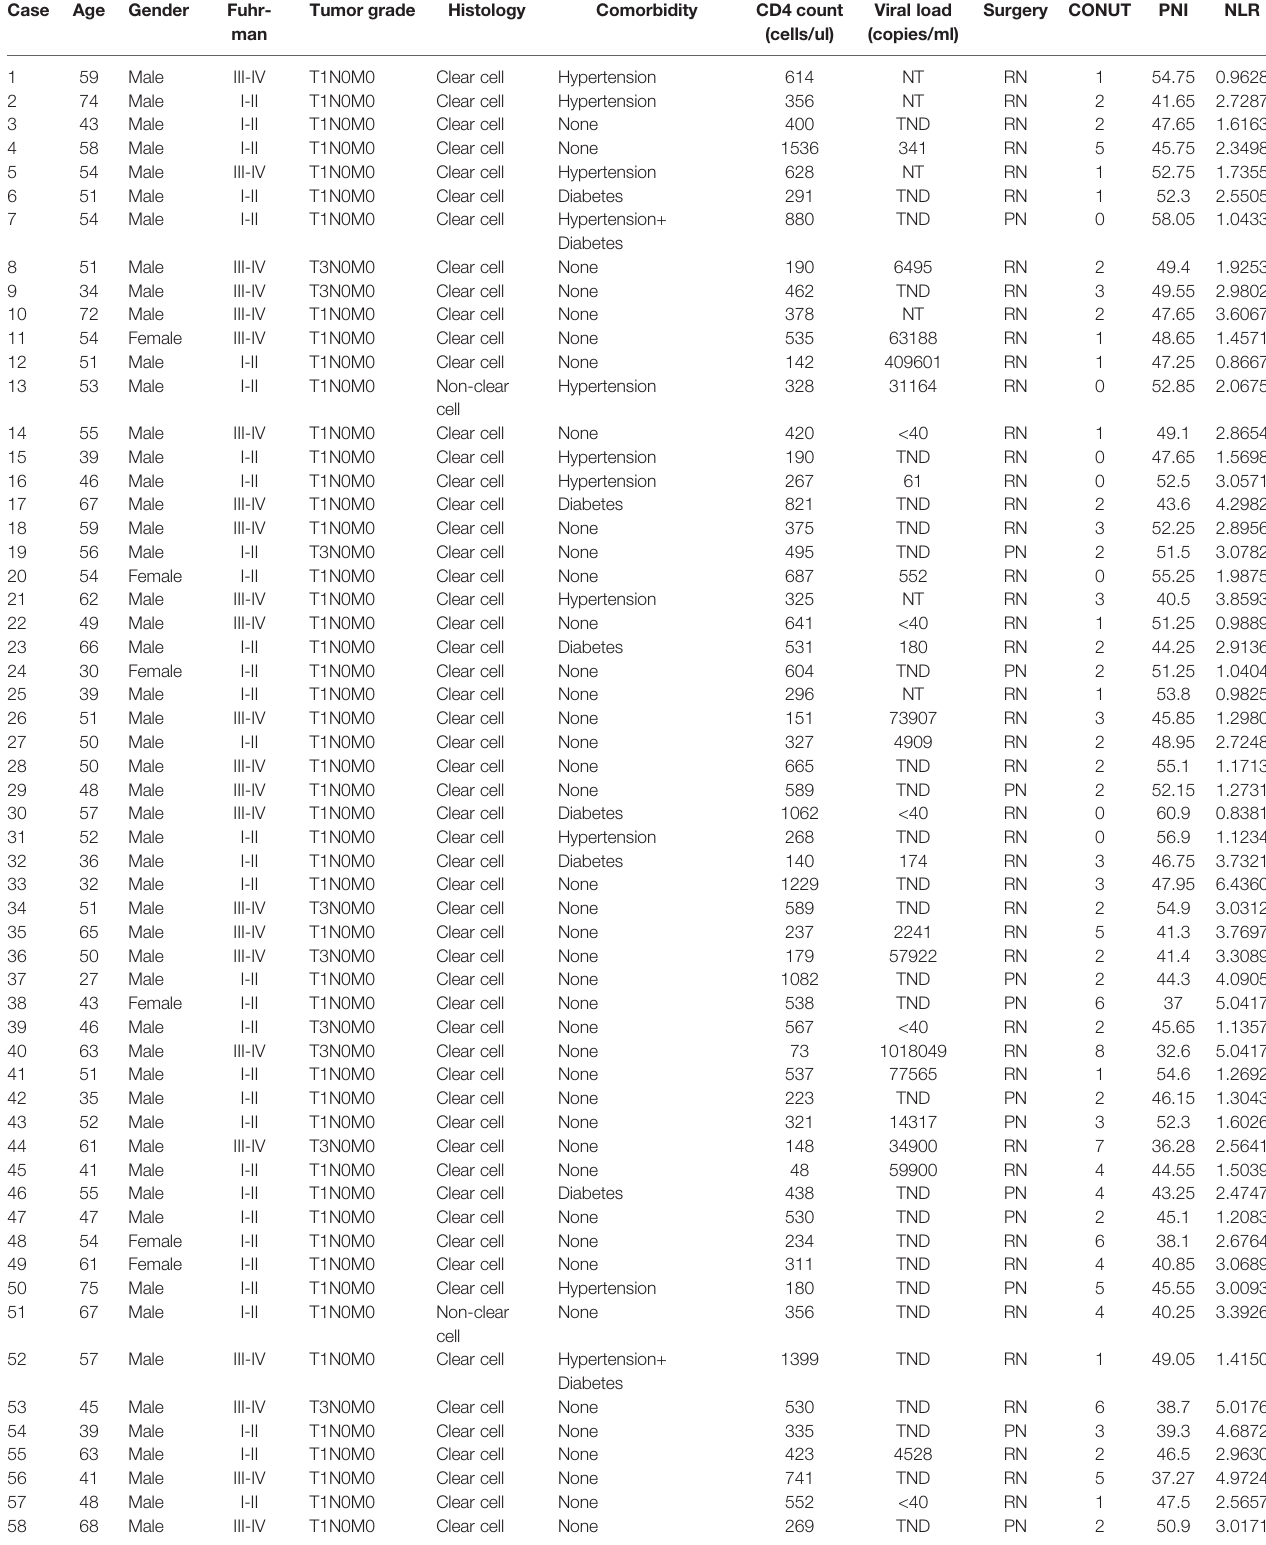
TABLE 2 | Basic information of the cases and HIV- related